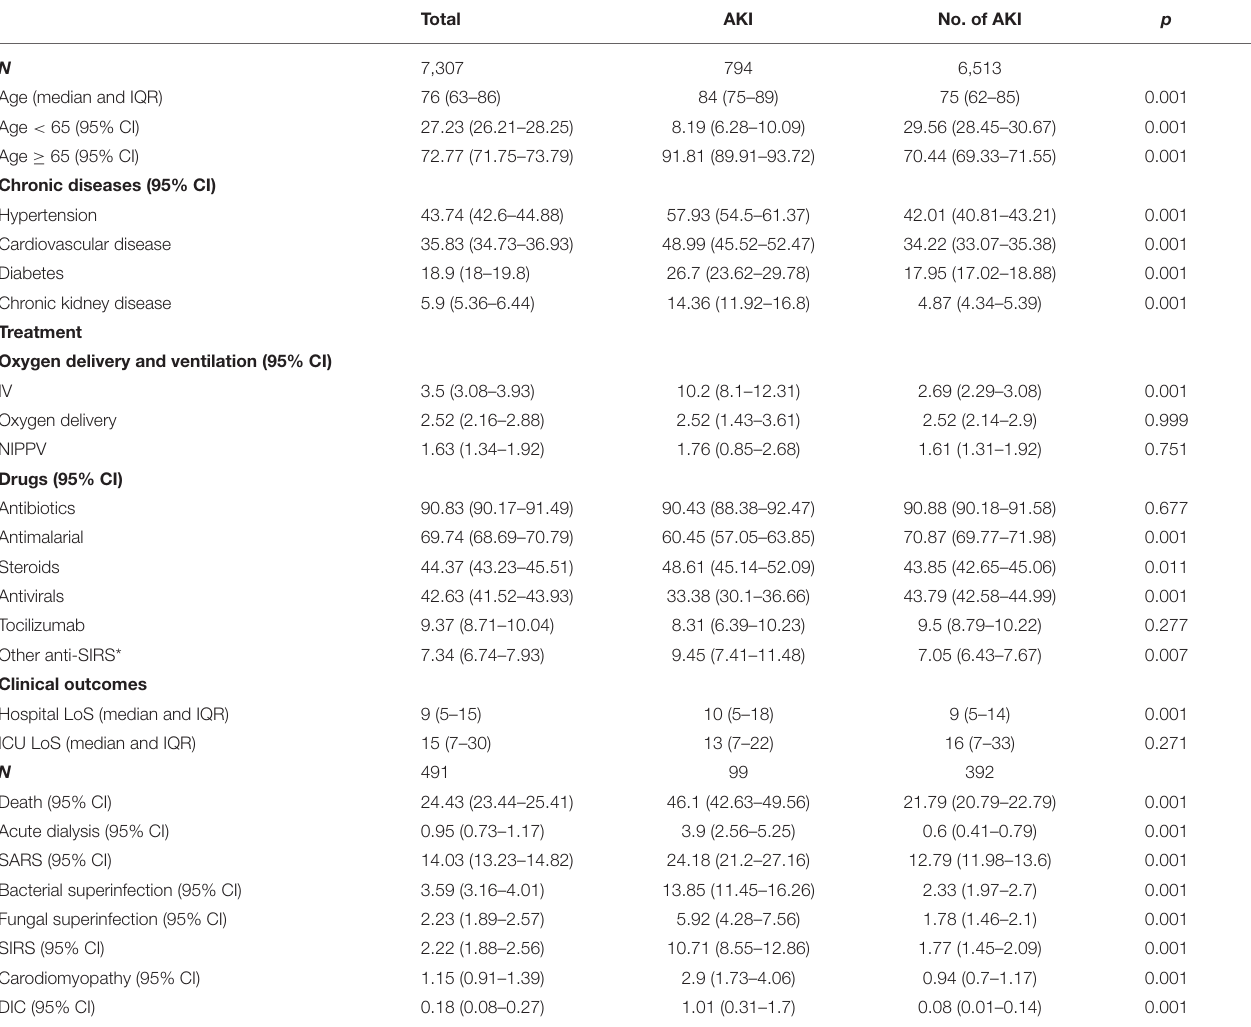
TABLE 1 | Baseline characteristics, treatment, and clinical outcomes of in-hospital COVID-19 patients with acute kidney injury in Castile and Leon (Spain) (March 1st–May 3th 2020). Total AKI No. of